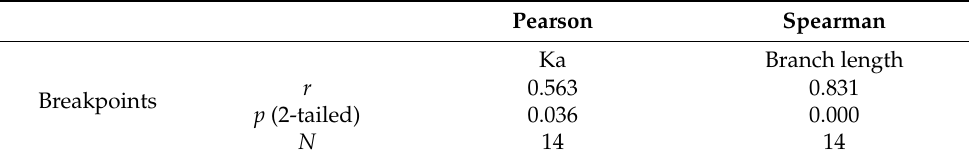
NOTE. Ka, rate of non-synonymous substitutions; Breakpoints, the rate of gene rearrangement; r , correlation coefficient; p < 0.05 (significant) and p < 0.01 (highly significant); N , sample size.